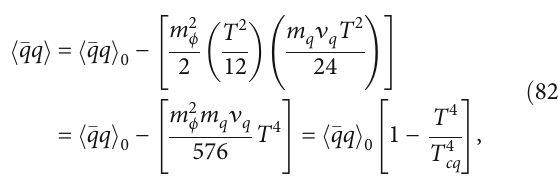
= 0 : 1 (a) and m ⟶ ∞ q q